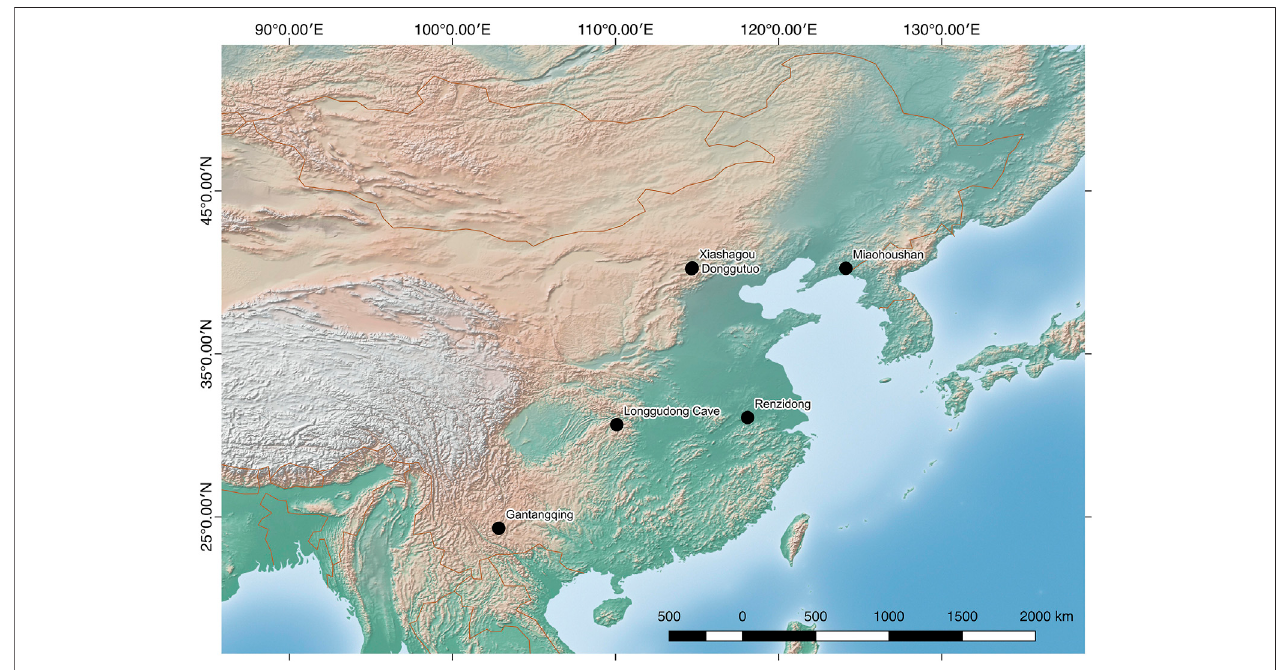
FIGURE1| DistributionofChineseLowerPaleolithicsiteswhereosseoustechnologywasreportedintheliterature(see Table1 fordetails).MapmadebyLDusing QGIS v. 2.14.3-Essen (Free Software Foundation, Inc., Boston) and free vector and raster from Natural Earth (naturalearthdata.com).